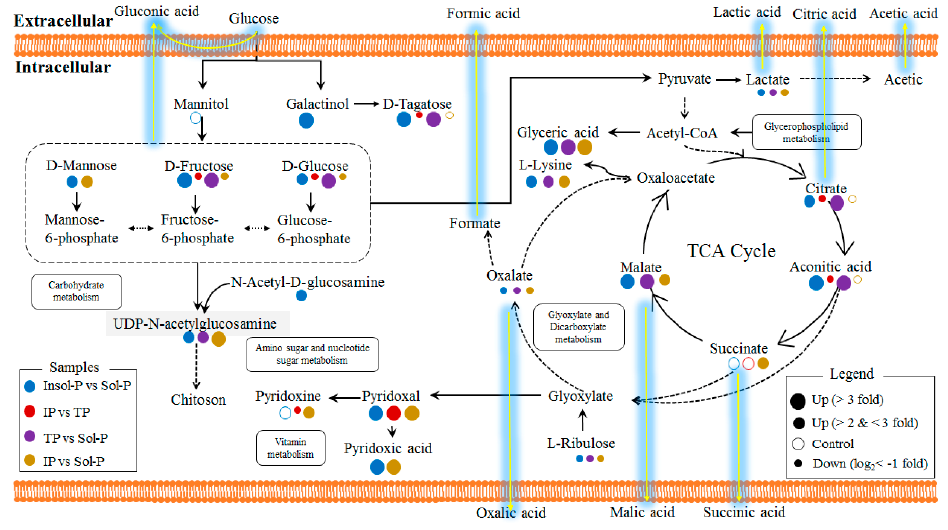
Figure 5. Intracellular metabolic pathways regulated by P sources in P. oxalicum . Identified metabolites from Q-TOF are marked with colored circles. Briefly, blue, red, purple, and yellow circles represent the metabolite intensity of the samples that are affected by insoluble P (Insol-P) vs. soluble P (Sol-P), iron phosphate (IP) vs. tricalcium phosphate (TP), TP vs. Sol-P, IP vs. Sol-P, respectively. The diameters of the cycles represent the intensities of the intracellular metabolites in four comparisons. The solid circles represent the significant increase (FC > 2 fold, p < 0.05) and decrease (log 2 (FC) < − 1, p < 0.05) intensities of important metabolites comparing to each control treatments. The hollow circles represent no significant changes (0.5 < FC < 2, p < 0.05) of the metabolic intensities. Solid lines show the intracellular metabolic pathways that exist in P. oxalicum , while the dotted lines show the supposed metabolic pathways. The yellow gleam lines represent the supposed extracellular acid production pathways collecting with intracellular metabolic pathways.